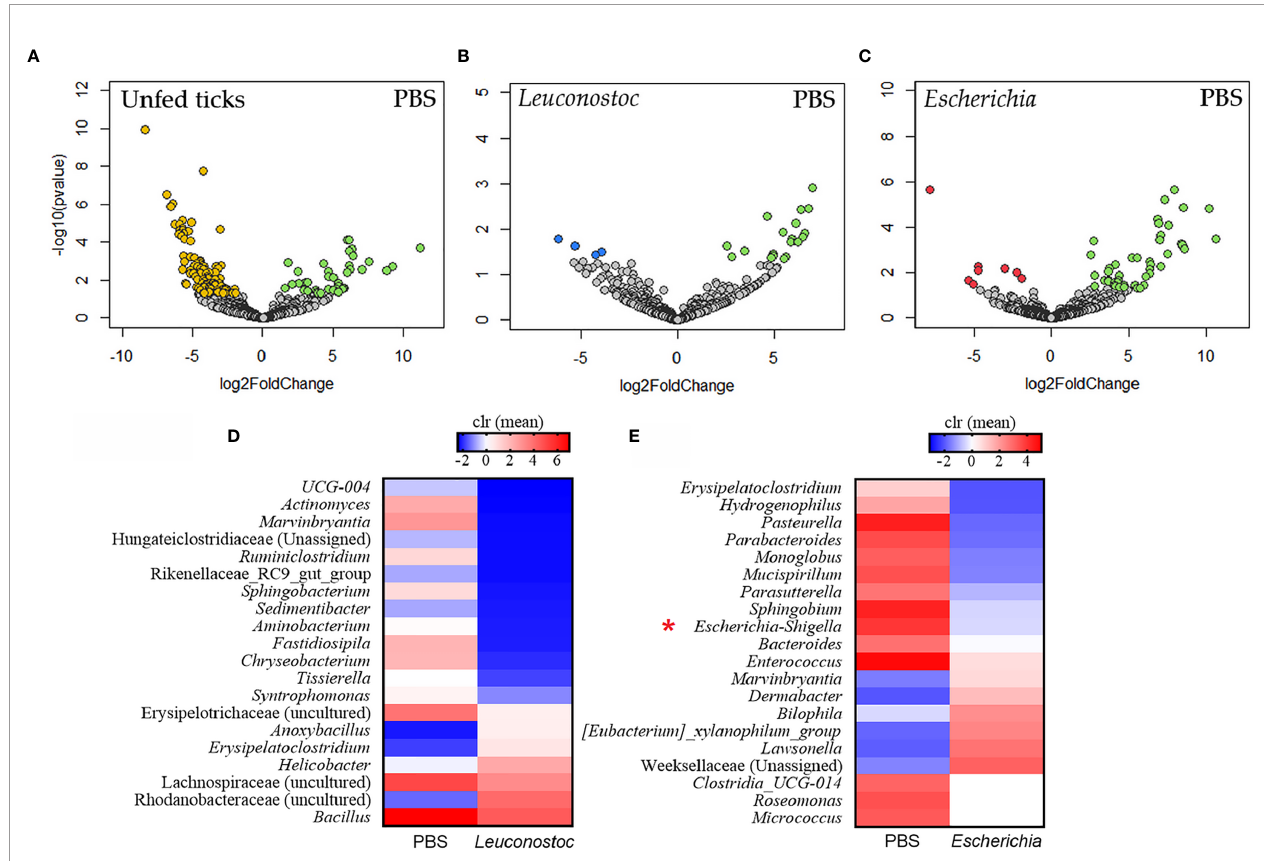
FIGURE 4 | Impact of anti-microbiota vaccines on the taxonomic pro fi les of tick microbiome. Volcano plot showing differential bacterial abundance in ticks of the different groups: (A) unfed ticks vs. ticks fed on mock-immunized mice (PBS), (B) ticks fed on mock-immunized vs. L. mesenteroides -immunized mice, and (C) ticks fed on mock-immunized vs. E. coli -immunized mice. The yellow (unfed ticks), blue (ticks fed on L. mesenteroides -immunized mice), and red (ticks fed on E . coli - immunized mice) dots indicate taxa that displayed both large magnitude fold-changes and high statistical signi fi cance favoring disturbed or control group (green dots), while the gray dots are considered as not signi fi cantly different between groups. Relative abundance (calculated as clr transformed values) of the 20 top bacterial taxa with the highest signi fi cant differences on ticks fed on mock-immunized vs. L. mesenteroides -immunized mice (D) and on ticks fed on mock- immunized vs. E. coli -immunized mice (E) , as detected by the DeSeq2 algorithm (Wald test, p < 0.001). Escherichia - Shigella was marked in the fi gure (red asterisk). The taxonomic pro fi les of the tick microbiota were characterized using 16S rRNA sequences obtained from samples of unfed I . ricinus nymphs (n = 6 tick pools), and nymphs engorged on E. coli -immunized (n = 9 tick pools), L. mesenteroides -immunized (n = 5 tick pools), or mock-immunized (n = 7 tick pools)